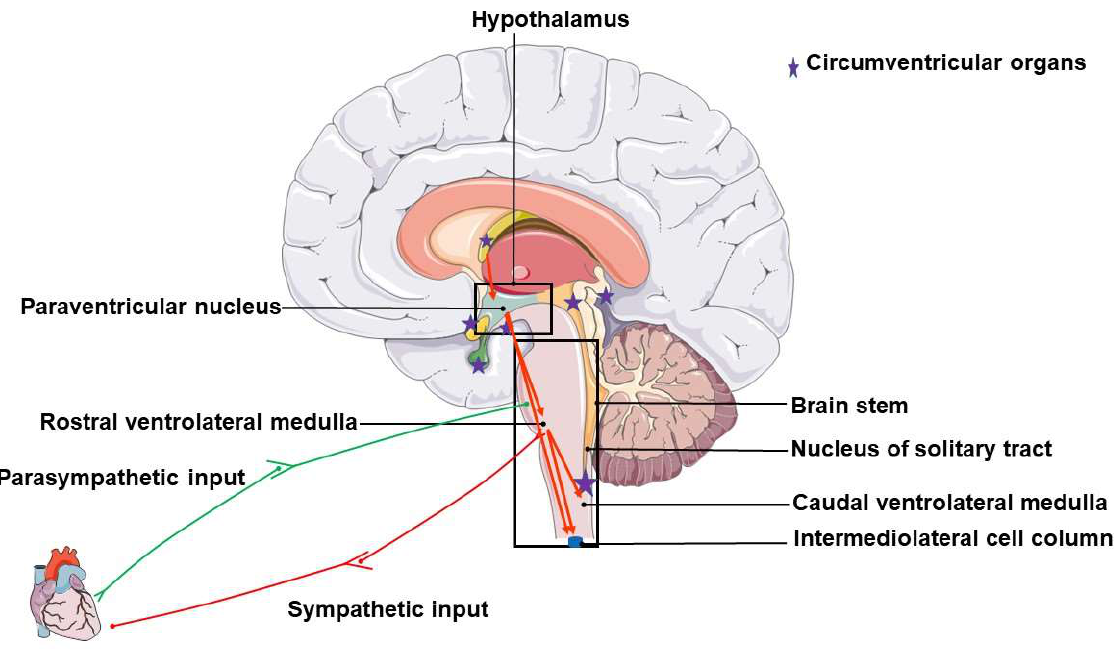
Figure 1. Brain regions that contribute to neurogenic hypertension. Purple stars indicate regions of the circumventricular organs.